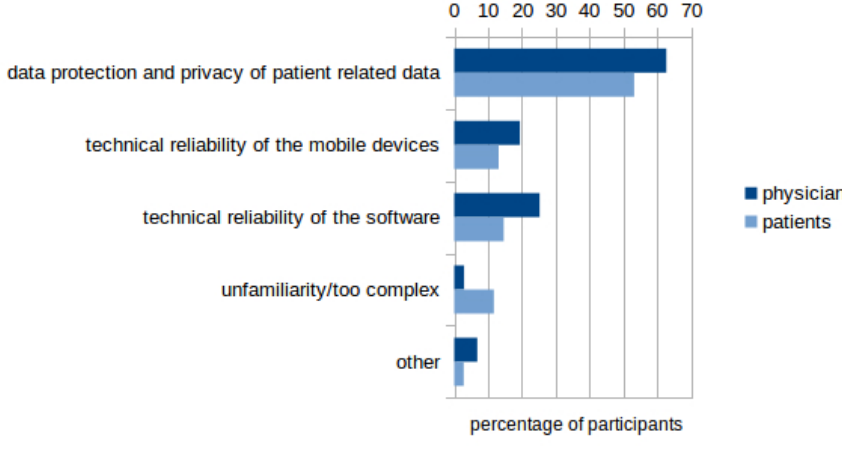
Figure 4. Concerns voiced by the participants about using mobile devices in a clinical